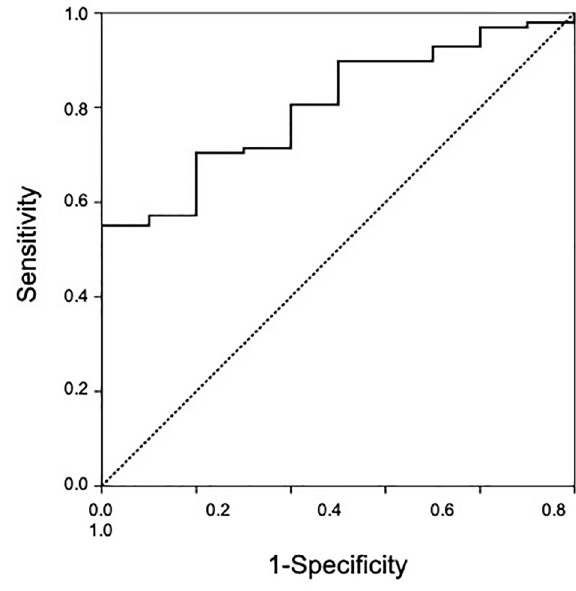
Figure 4 - Receiver operating characteristic (ROC) curve comparing typical adenomas and non-adenomas groups with an area under the curve of